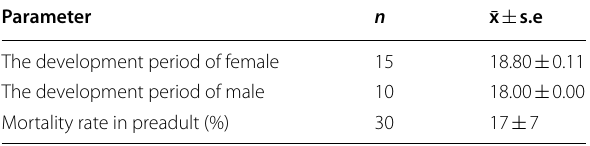
Standard errors (s.e.) were estimated by using the bootstrap technique with 100,000 re-samplings